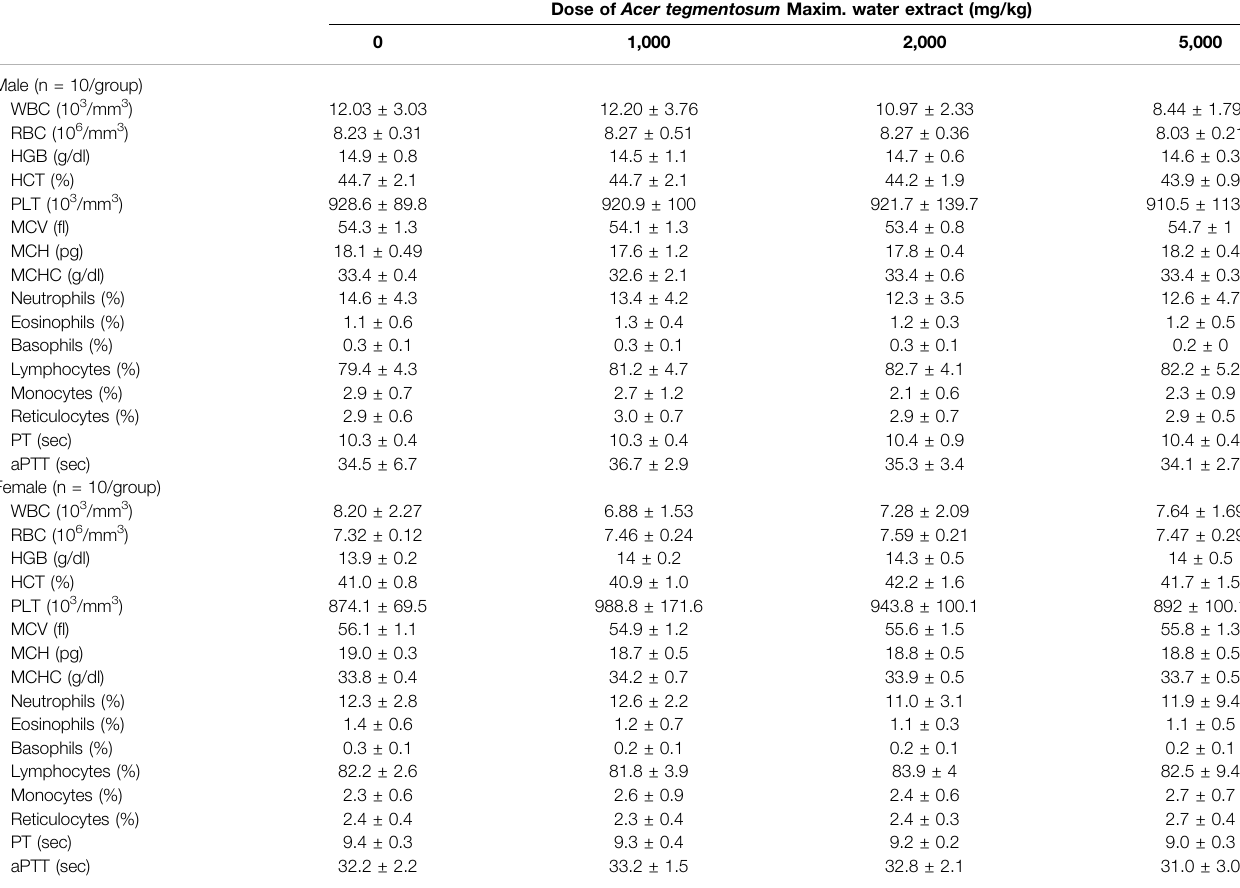
TABLE 2 | Hematological parameters of SD rats orally treated with Acer tegmentosum Maxim. water extract for 90